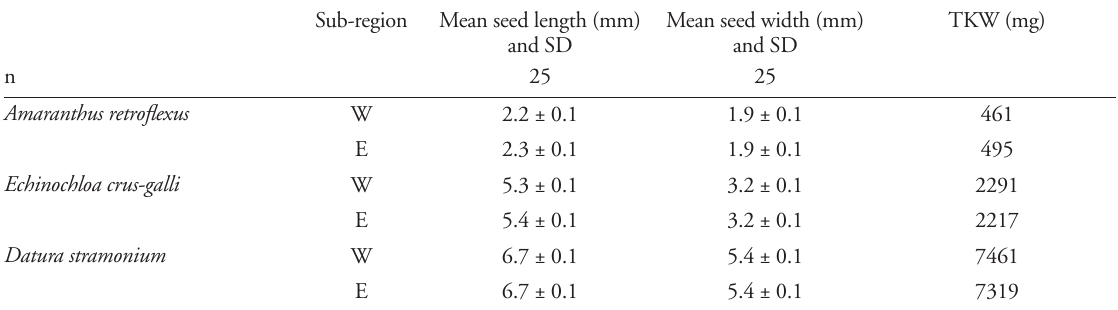
Table 1. Seed morphological characteristics of A. retroflexus , E. crus-galli , and D. stramonium , originating from two sub-regions of Kosovo. According to t-tests, seed characteristics of all three species do not differ between the two sub-regions. W = western part of Kosovo, E = eastern part of Kosovo, TKW = thousand-kernel weight.